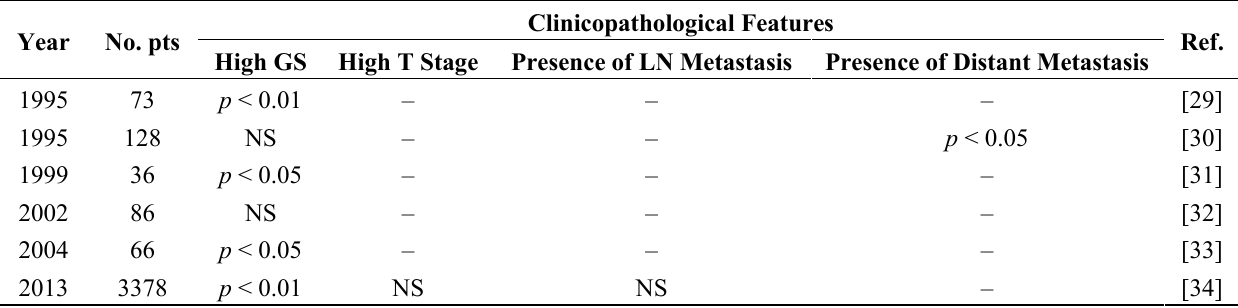
Table 2. Relationship between Met expression and pathological features in prostate